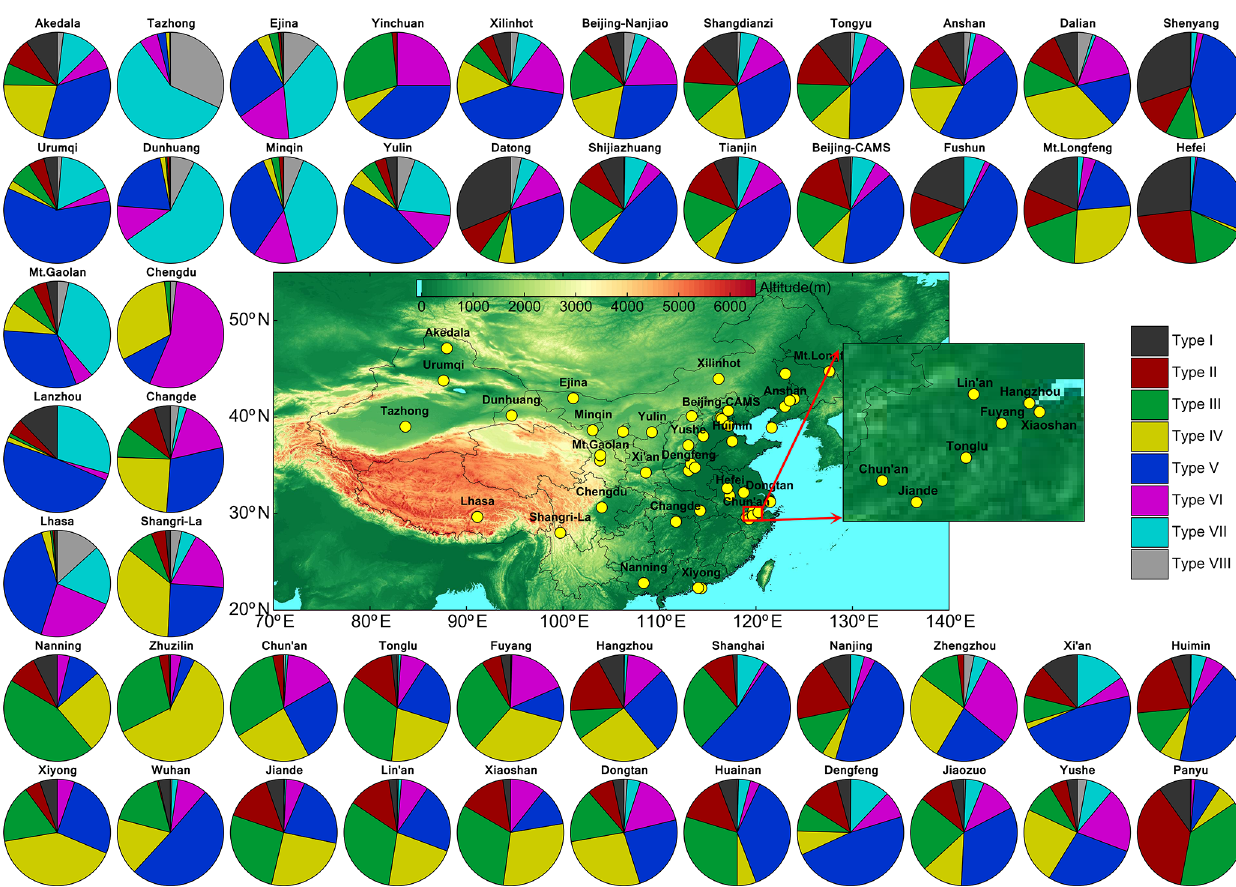
Figure 9. Annual spatial distribution of the aerosol type classification of types I–VII at the CARSNET